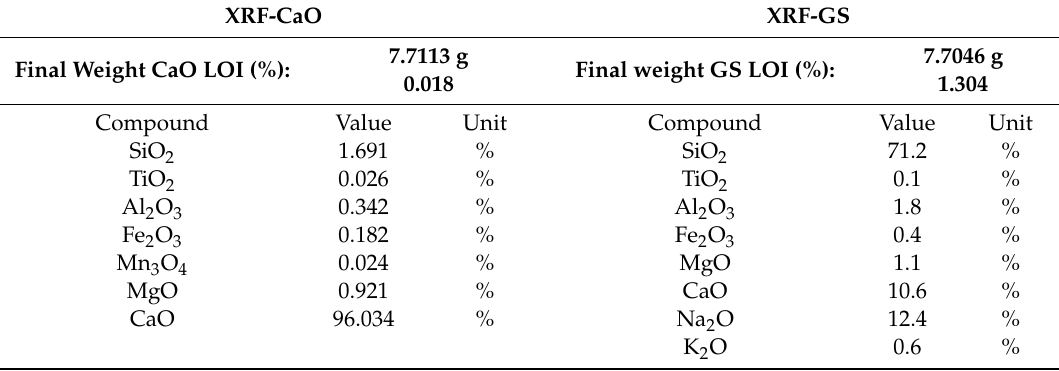
Table 4. X-ray fluorescence (XRF) analysis of the composition of lime and glass compounds [64].